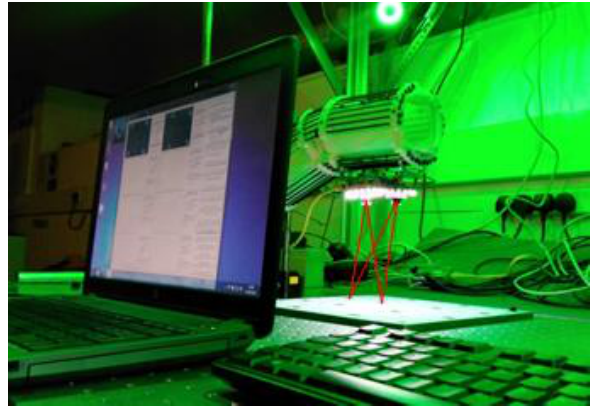
Figure 9. Measurement process, Direct